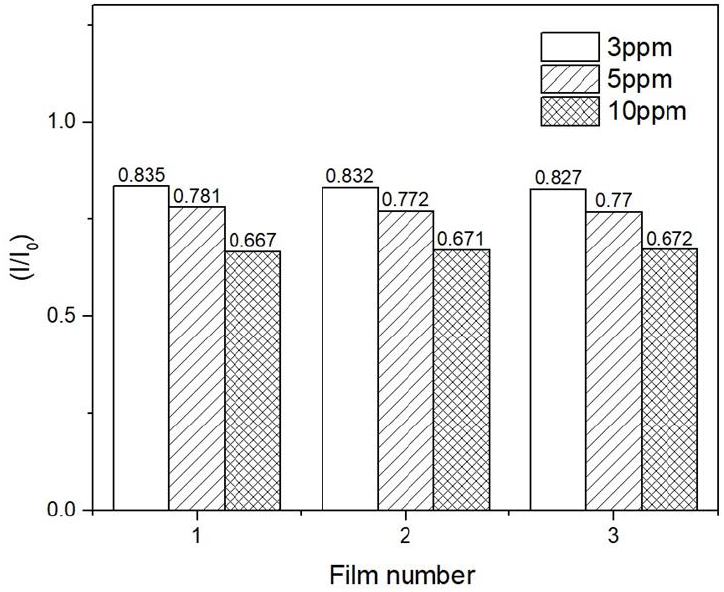
Figure 10. The recycling process for one sensing film.